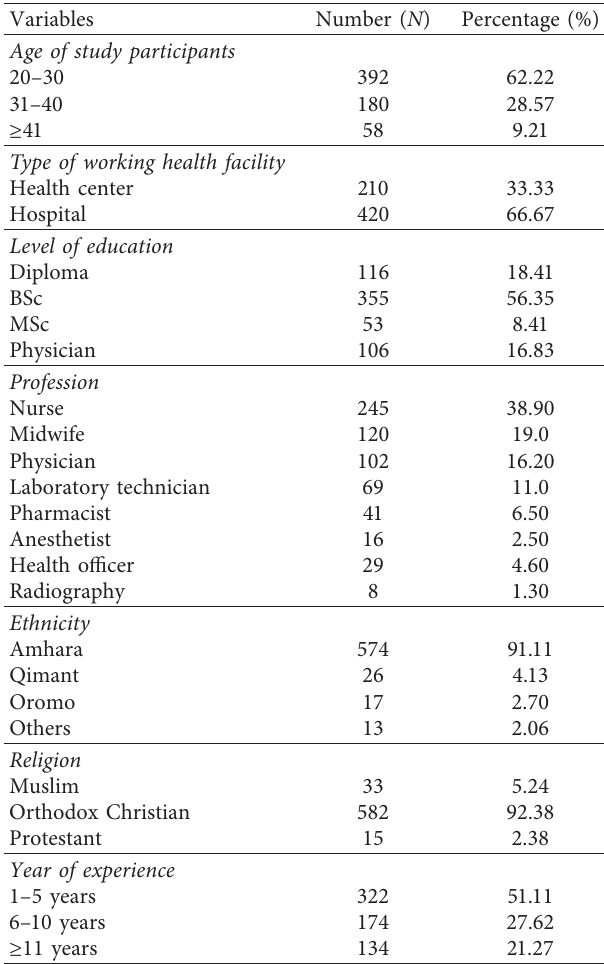
Table 3: Sociodemographic characteristics of HCWs in Northwest Ethiopia, 2020 ( n �